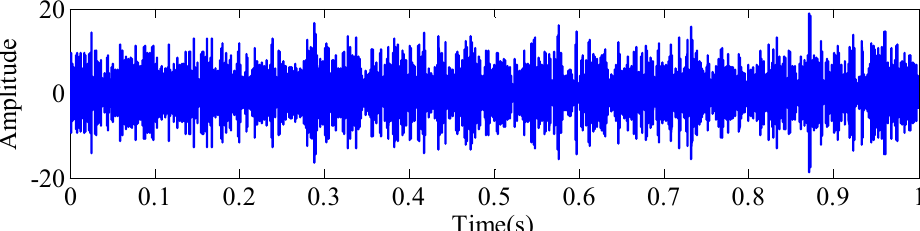
Figure 26. Time domain diagram of the signal segment selected by the algorithm in this paper.